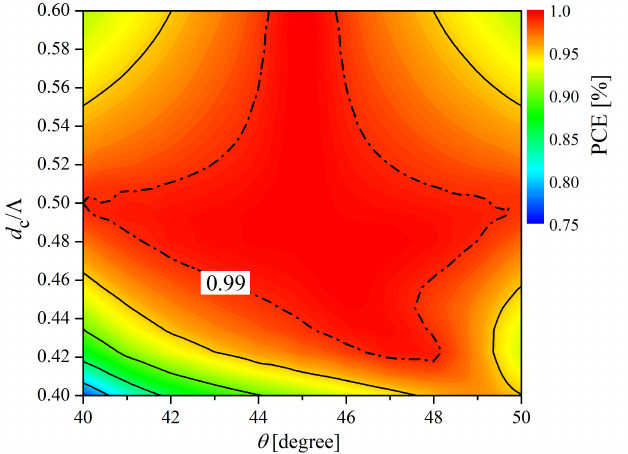
Figure 10. The variation of the PCE as a function of the deviation of angle θ with different hole